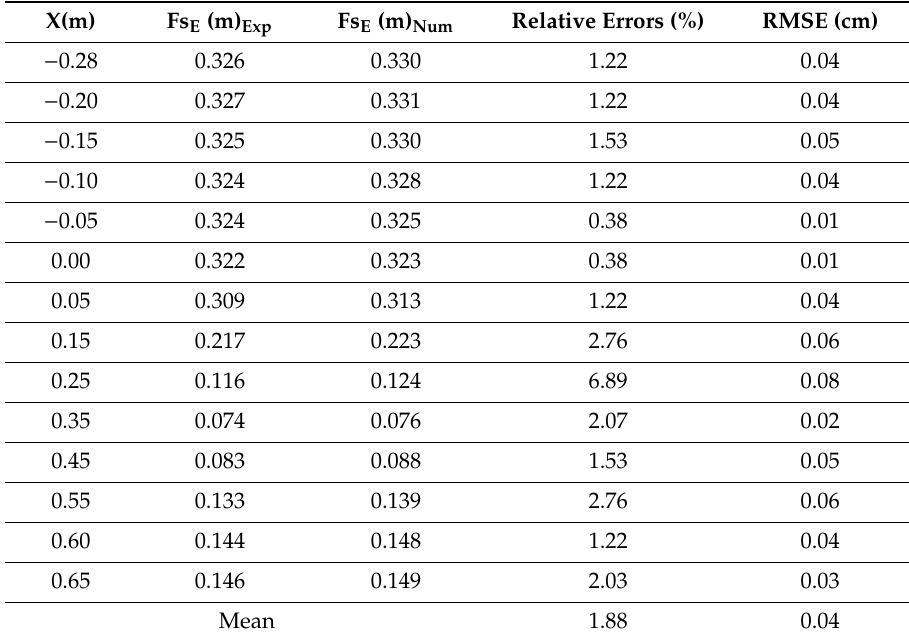
Table 3. Comparison of numerical and experimental free-surface profiles; Q = 0.085 m 3 / s.